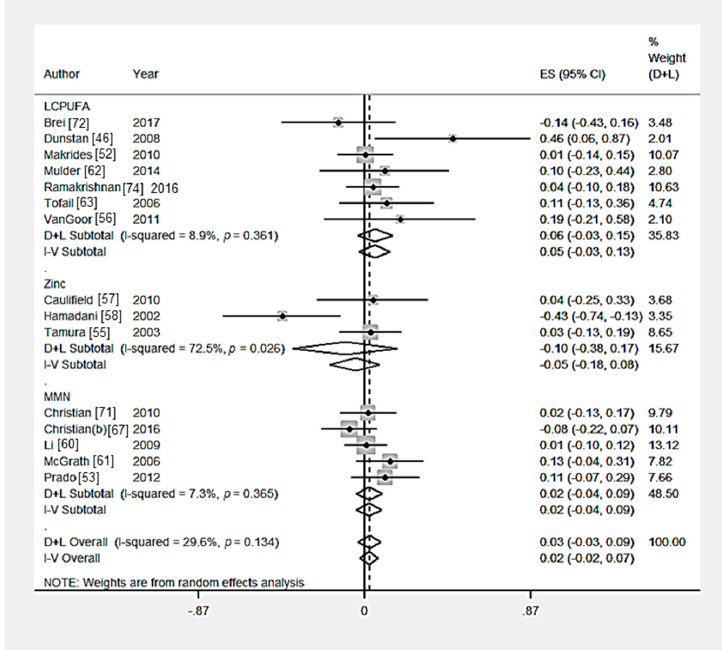
Figure 3. Forest plot for child motor skills outcomes. The overall effect size was estimated by standardised mean difference (SMD). LCPUFA, long chain polyunsaturated fatty acids; MMN, multiple micronutrient. D+L, random-effects estimate (Der Simonian and Laird method) and I-V, fixed-effects estimate (inverse variance method).